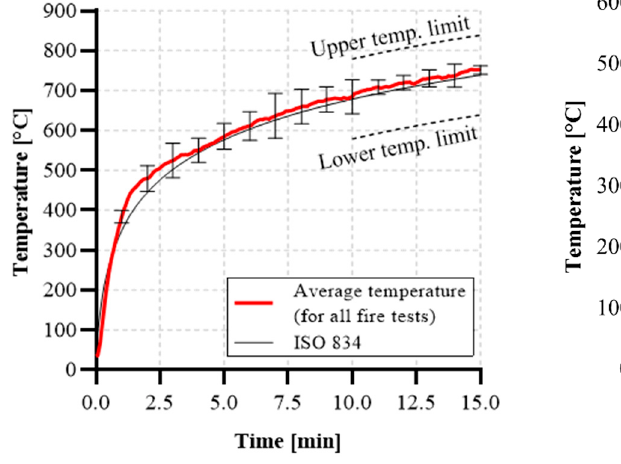
Figure 7. Measured temperature from the test furnace and tested specimens: ( a ) average tempera- ture curve in the test furnace; ( b ) measured average temperatures of the specimens on the inner surface of the textile reinforcement for different covering layers and concrete mixture variants.